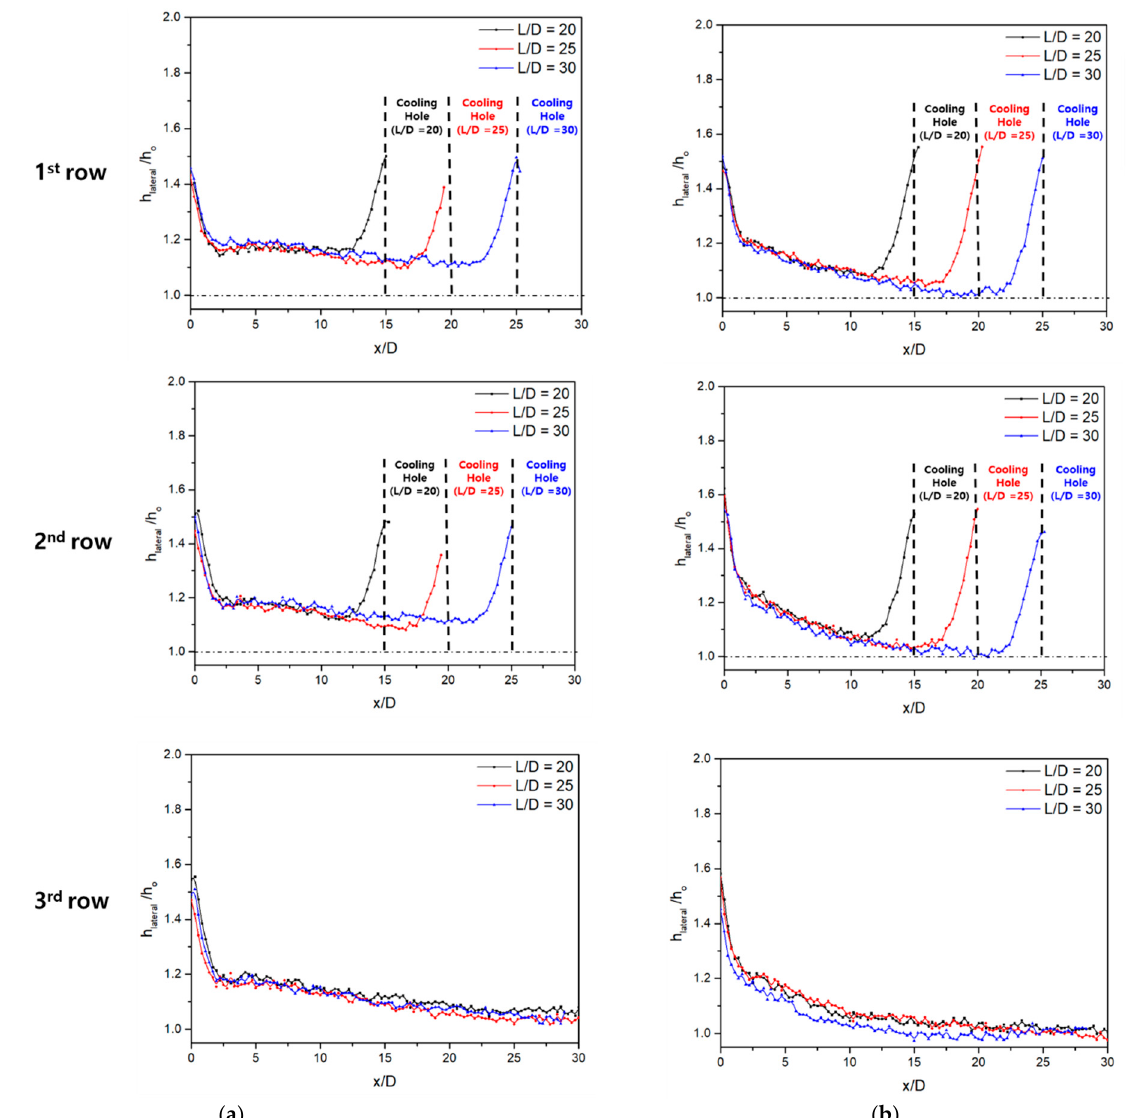
Figure 11. h lateral /h o for different row-to-row distance cases: ( a ) M = 1.0; and ( b ) M = 2.0.